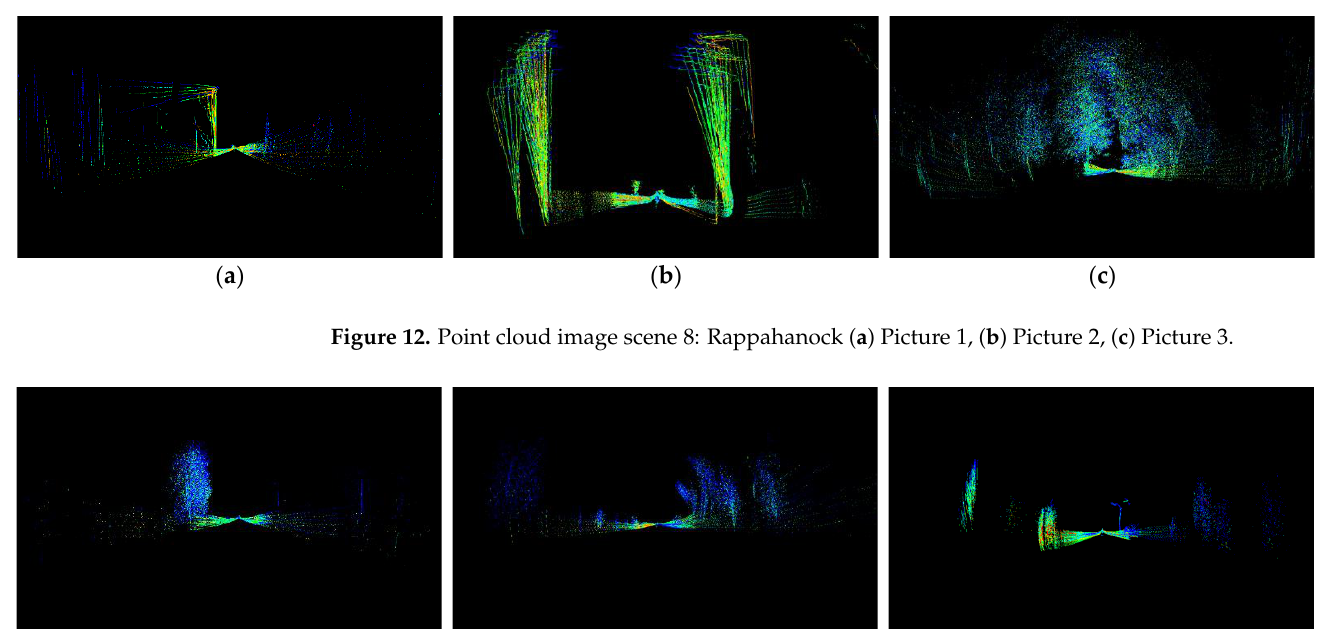
Figure 11. Point cloud image scene 7: Pond-counter-S16 ( a ) Picture 1, ( b ) Picture 2, ( c ) Picture 3.